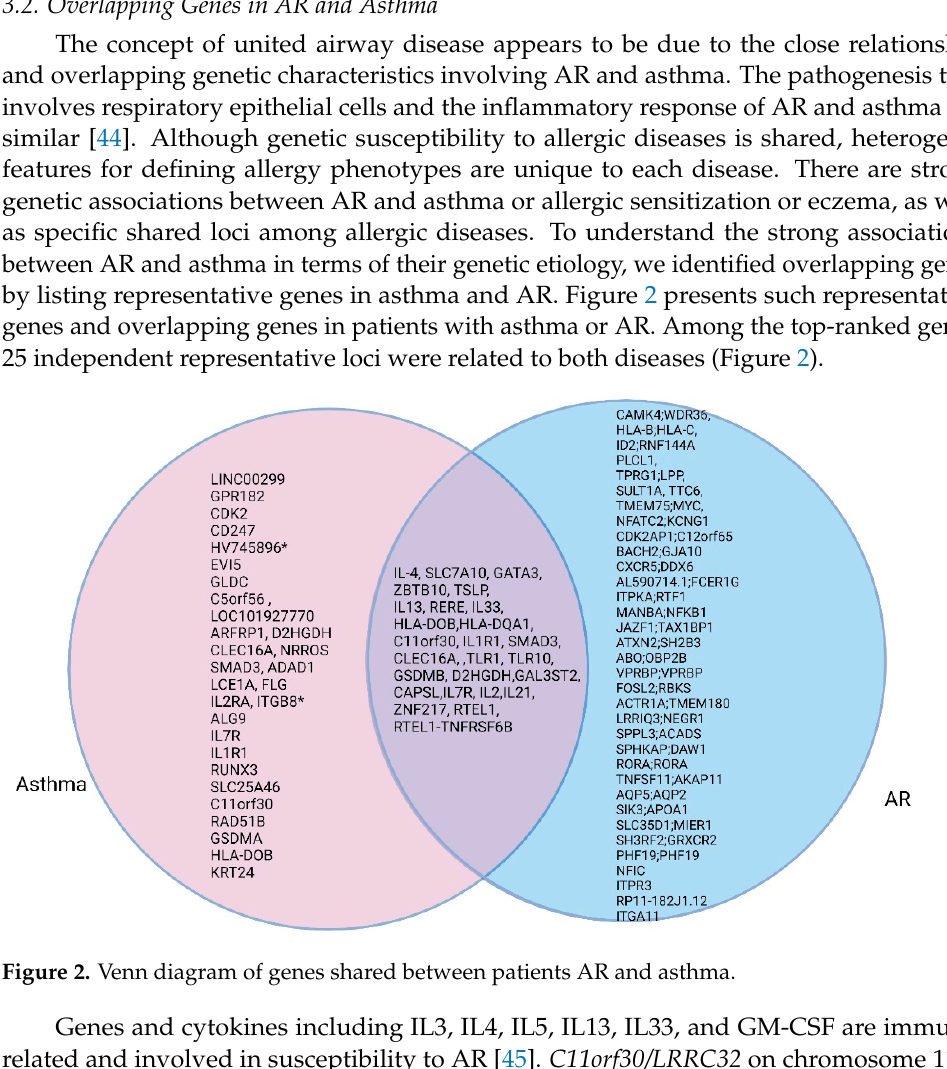
Figure 2. Venn diagram of genes shared between patients AR and